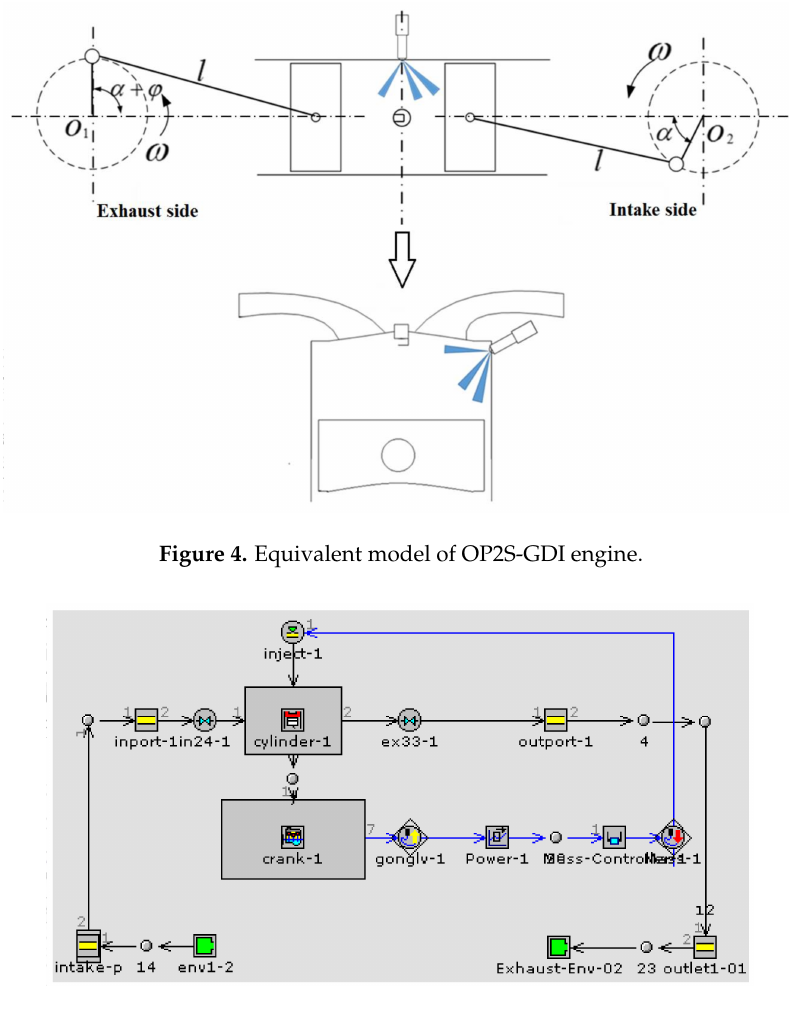
Figure 5. 1D working process model of OP2S-GDI